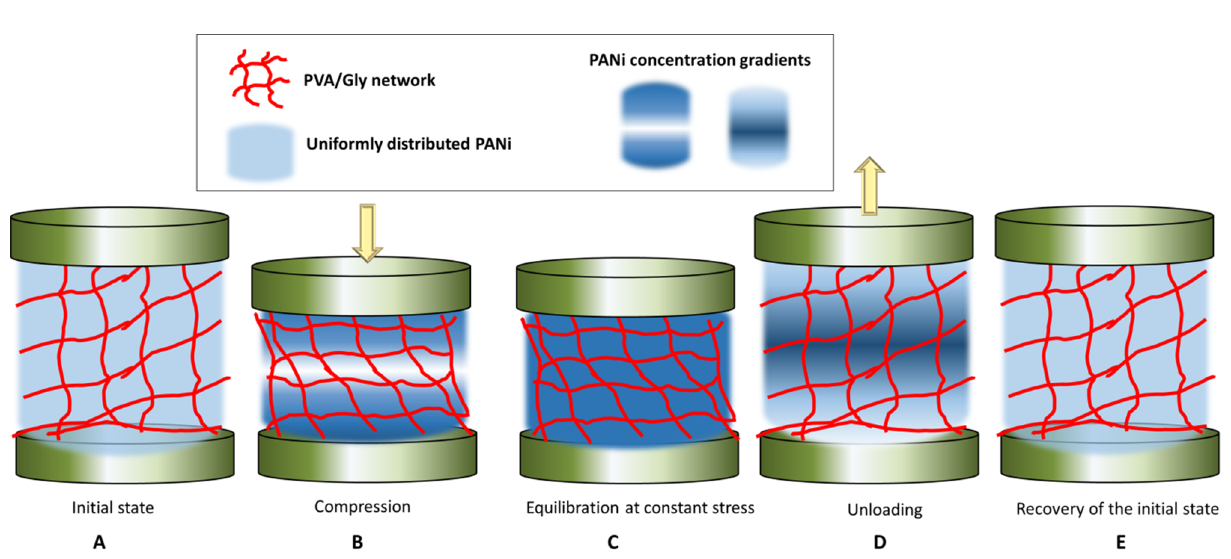
Figure 7. Depiction of the hypothetical relaxation mechanism of the PVA network and of the PANi polymer during compression-equilibration-decompression-relaxation cycles. Table 2. The values for τ , β and n obtained by fitting the Equation (1) to the portion of the relaxation at constant strain.